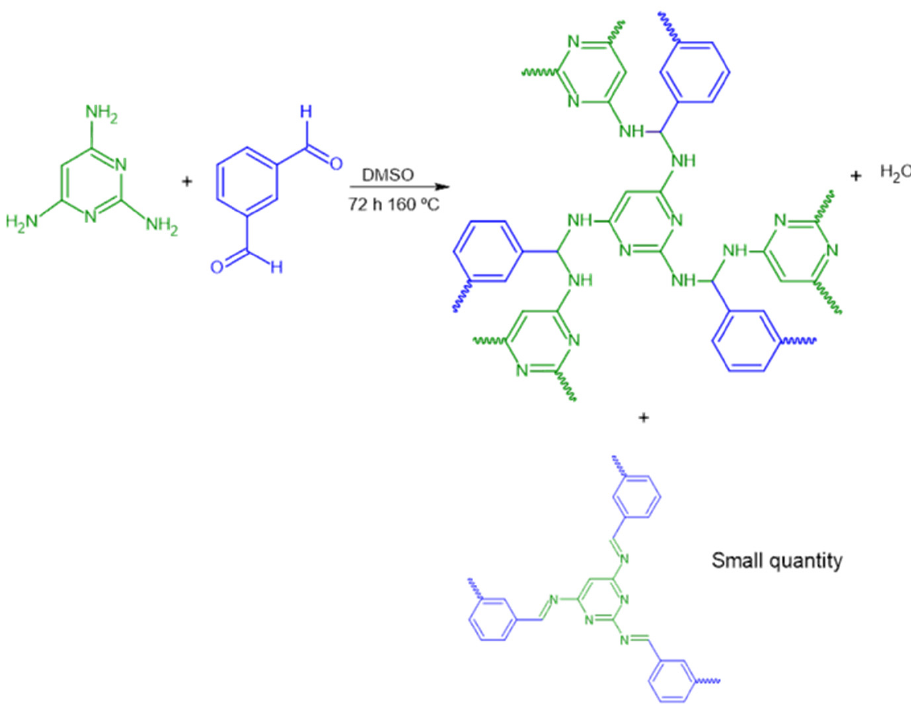
Figure 1. Schematic representation of the synthetic path.